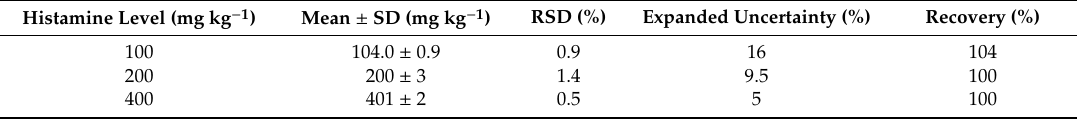
Table 1. Results obtained by the validation process. RSD: relative standard